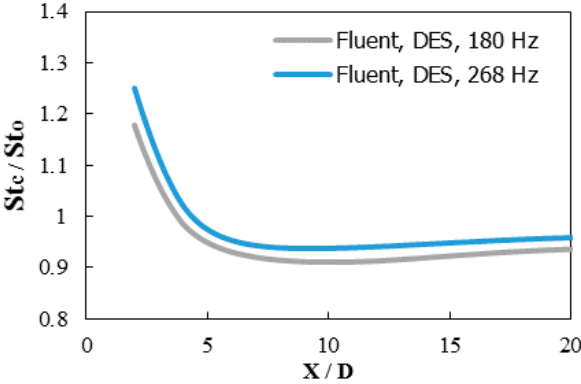
20 of 33 Figure 21. The spanwise-averaged effectiveness obtained using the LES Smagorinsky–Lilly model for M = 0.5 for the 180 and 268 Hz oscillations [28]. 4.3.2. Stanton Number Ratio If the frequency goes from 180 to 268 Hz, the centerline and the spanwise-averaged Stanton